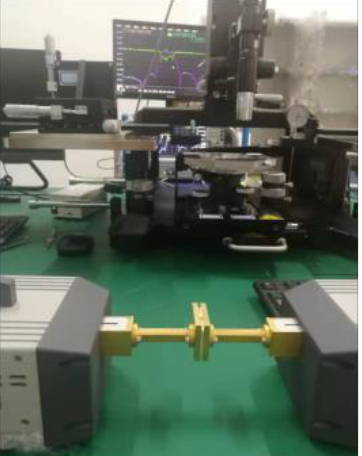
Figure 11. Photograph of the measurement setup.